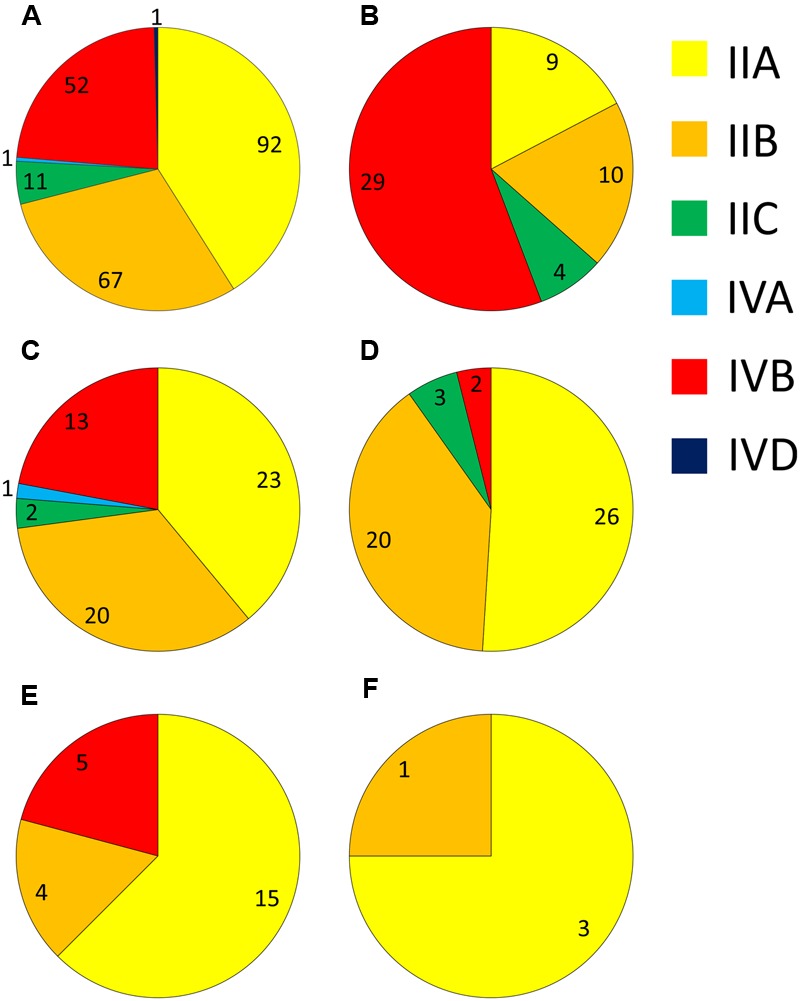
Distribution of different serogroups among isolates from: (A) all sources; (B) human clinical; (C) dairy; (D) meat; (E) animal; and (F) vegetable sources. Numbers of isolates are marked for each serogroup segment.